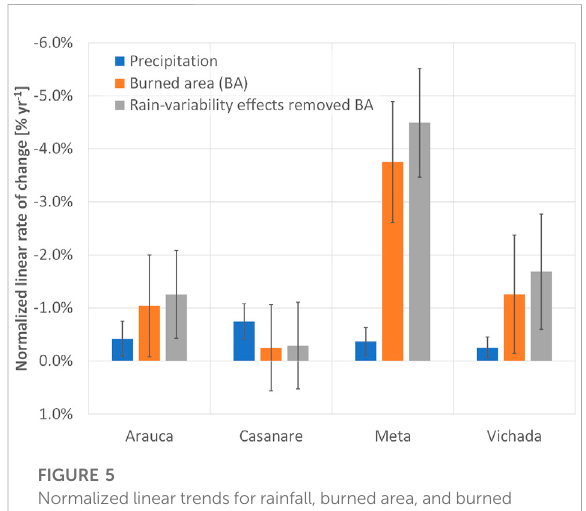
FIGURE 5 Normalized linear trends for rainfall, burned area, and burned area corrected for rainfall variability during the 1997 – 2016